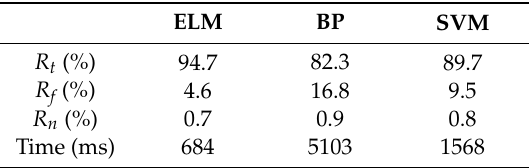
Table 2. Statistical results of track segment association based on di ff erent machine learning methods. BP: back propagation; SVM: support vector machine.